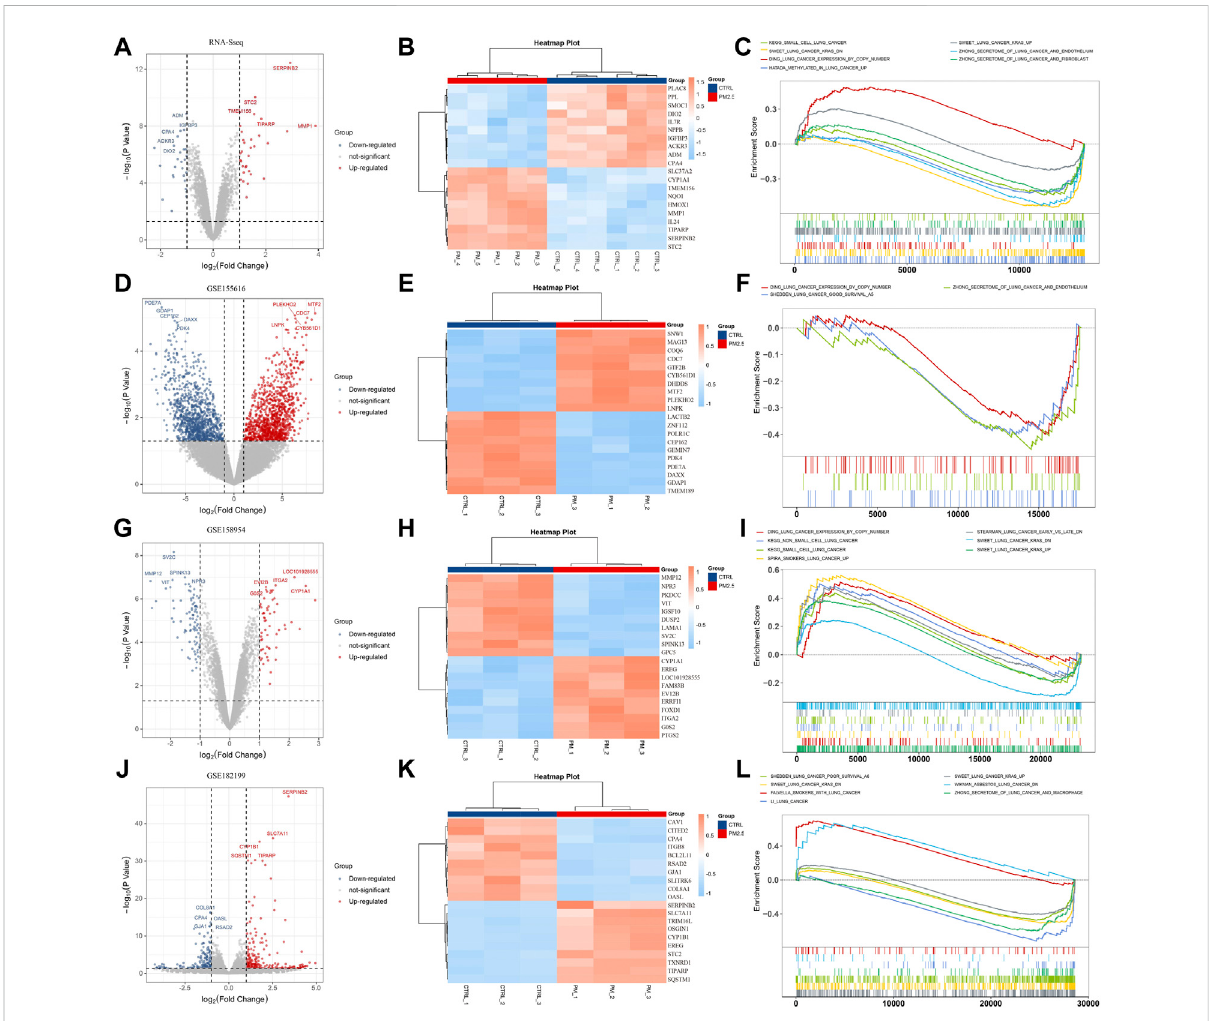
FIGURE 1 PM2.5 exposure is associated with lung cancer. (A,D,G,J) Volcano plots showing DEGs from our own RNA-seq data and public datasets (GSE155616, GSE158954, and GSE 128199); (B,E,H,K) Heatmaps showing top 10 DEGs. (C,F,I,L) GSEA analysis showing PM2.5 exposure was associated with lung